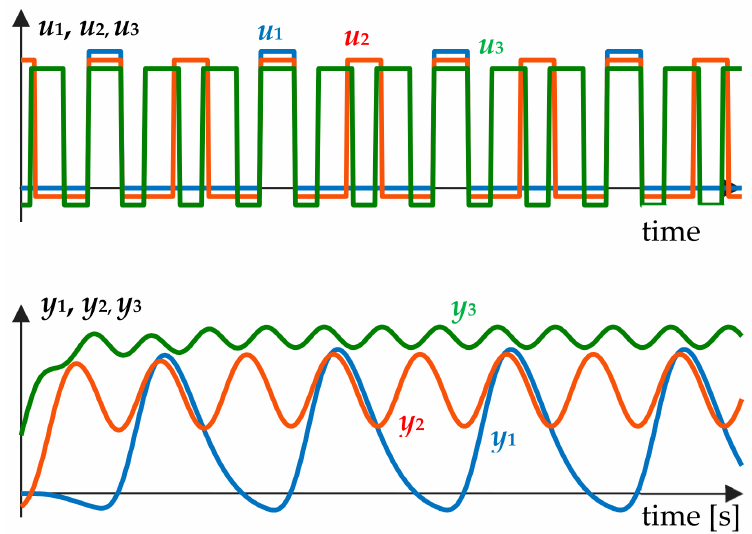
Figure 4. The time courses of u 1 and y 1 during the relay feedback control together with calculated u 2 , y 2 , u 3 , y 3